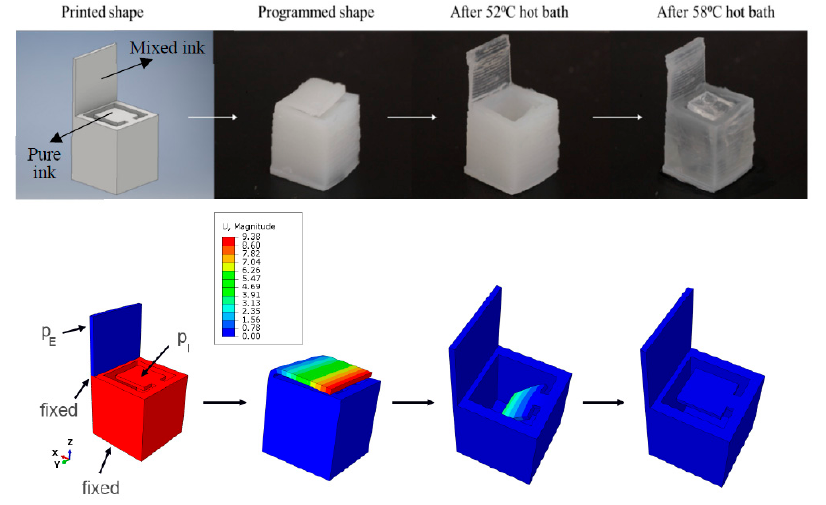
Figure 29. Thermally-induced transitions in a double-lid multi-material DLP printed box. Both lids remain closed below 52 °C; at 52 °C, both lids open. The inner lid closes at 58 °C. Reproduced from [70].